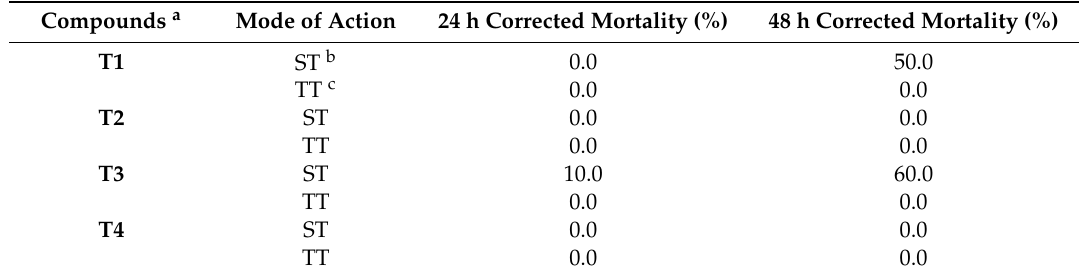
Table 4. Toxicity of compounds against P.